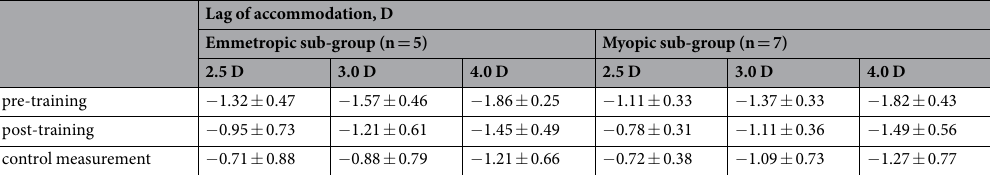
Table 4. Lag of accommodation in subjects successfully trained in multifocal contact lens wear. Values of the lag of accommodation (mean ± SD) in the five emmetropic and seven myopic responsive subjects (i) in the baseline reading, (ii) in the post-training measurement without biofeedback, and (iii) in the control measurement, also without biofeedback, recorded five to eight days after the training in multifocal contact lens wear.